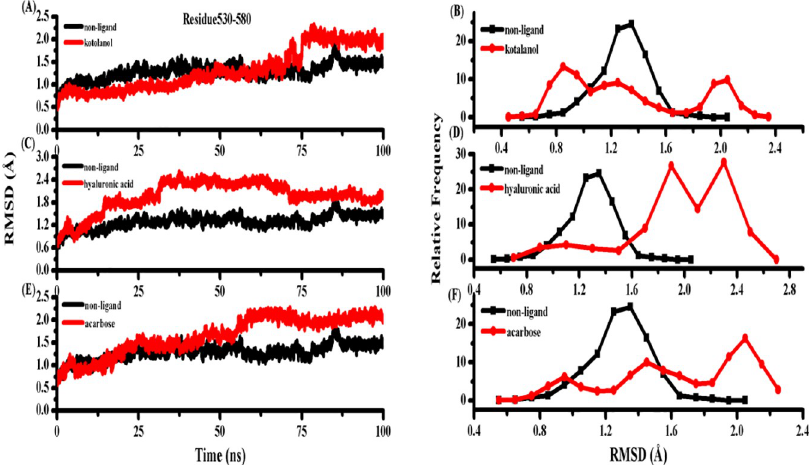
Fig 6. (A) RMSD plot of residue 530–580 between free SI and SI-kotalanol. (B) the relative frequency of RMSD plot of residue 530–580 between free SI and SI- kotalanol. (C) RMSD plot of residue 530–580 of free SI and SI-HA. (D) the relative frequency of RMSD plot of residue 530–580 between free SI and SI- HA. (E) RMSD plot of residue 530–580 between free SI and SI-acarbose. (F) the relative frequency of RMSD plot of residue 530–580 between free SI and SI-